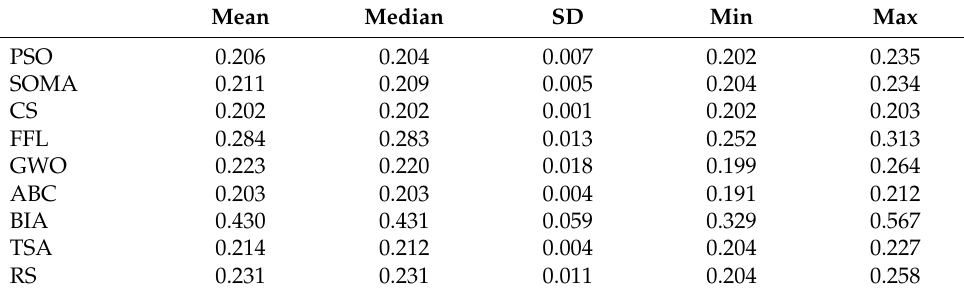
Table 2. Comparison of algorithms for Function f 1 .